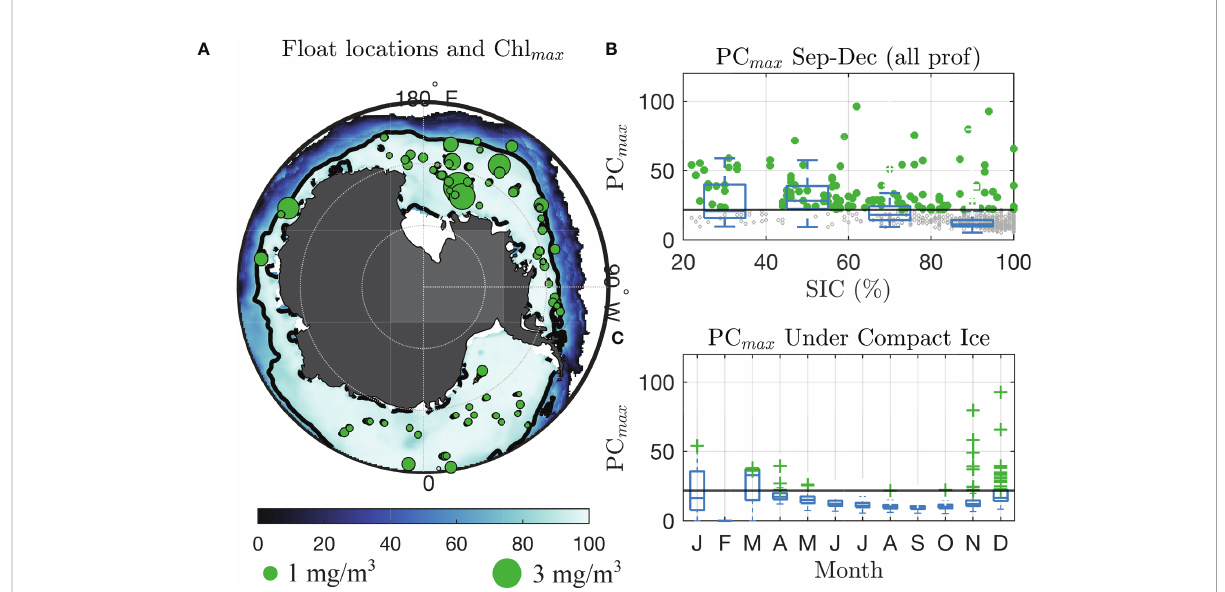
FIGURE 1 Chlorophyll-a and phytoplankton carbon recorded under compact sea ice by BGC-Argo fl oats. (A) Climatological sea ice coverage in September – November, 2014 – 2020. Black line shows 80% concentration contour. Green circles are locations of under-ice Argo fl oat pro fi les under compact sea ice after October 1, with sizes scaled with value of Chl max . Green dots outside of map shows sizes corresponding to 1.0 and 3.0 mg/m 3 . (B) Box plot of PC max for all BGC-Argo measurements under sea ice, indexed by sea ice concentration. Whiskers extend boxes ±3 standard deviations from the mean in each month, and the vertical blue line is the ensemble median. Crosses show values identi fi ed as “ UIBs. ” The black line is the PC max bloom threshold. (C) Same as (B) , but for PC max recorded under compact sea ice (concentration >80%) only, indexed by